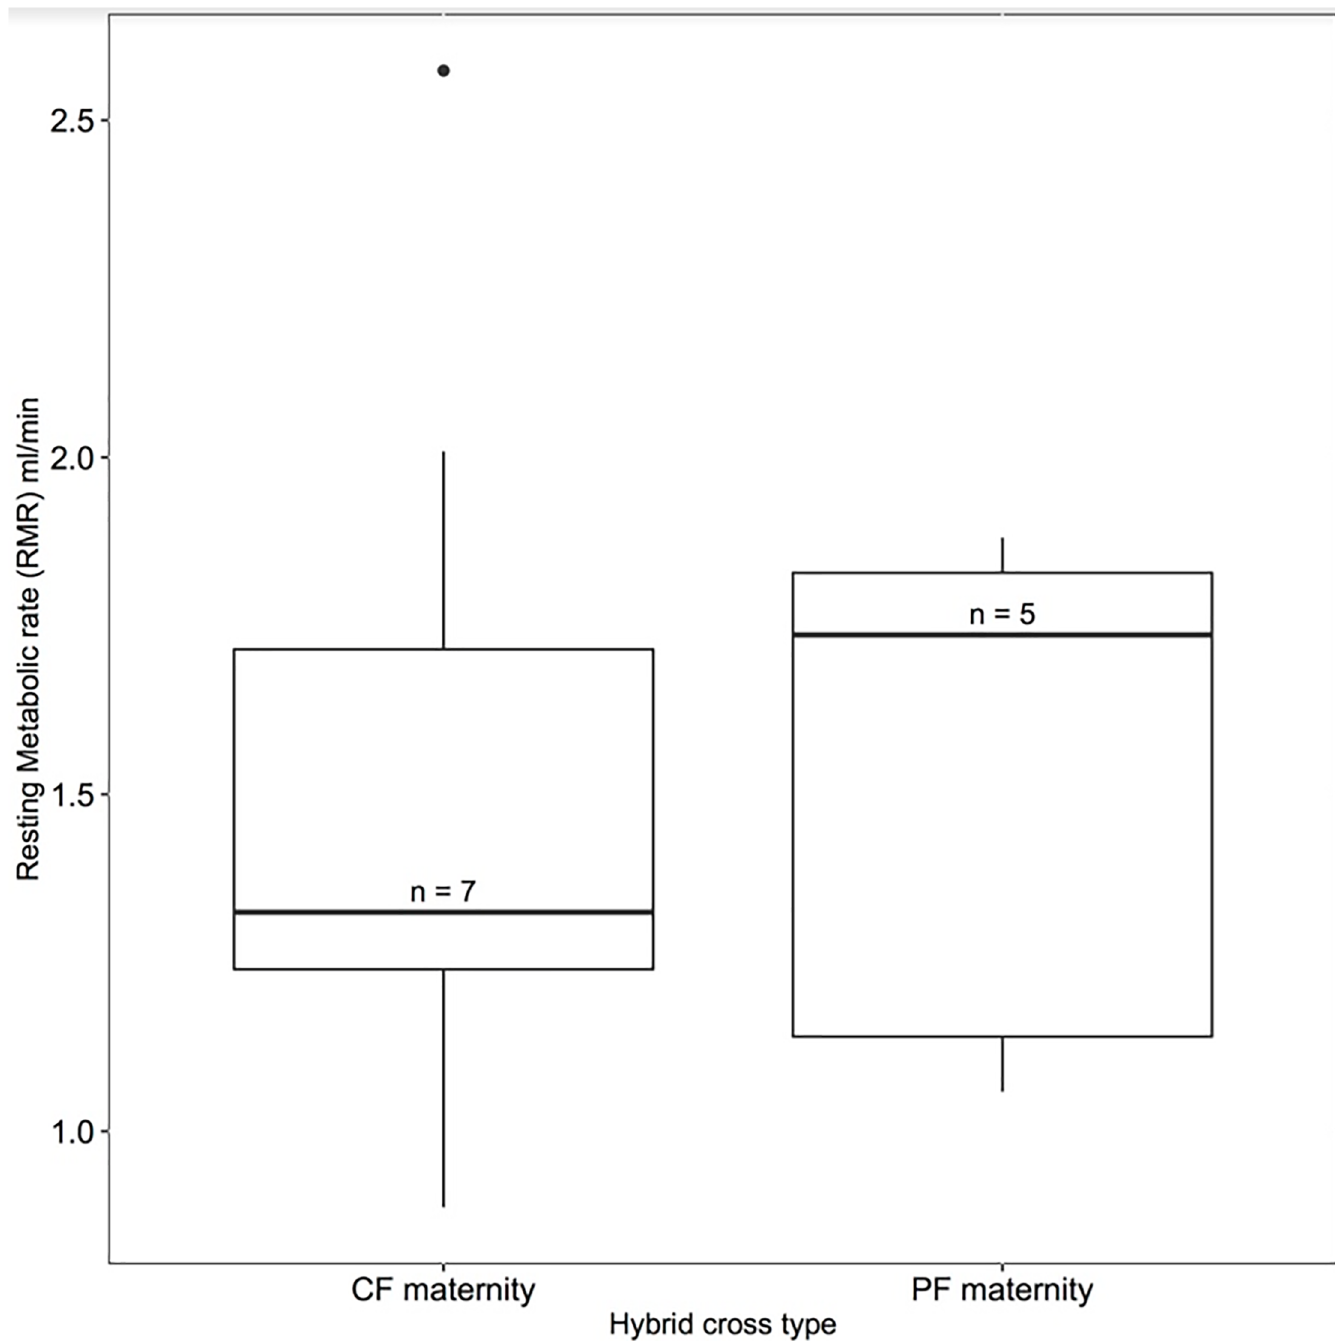
Fig 2. We tested whether male hybrids with collared flycatcher mtDNA (CF mtDNA, n = 7) or pied flycatcher mtDNA (PF mtDNA, n = 5) had different whole animal metabolic rates (ml/minute). We found no significantevidenceof a difference betweencross types.